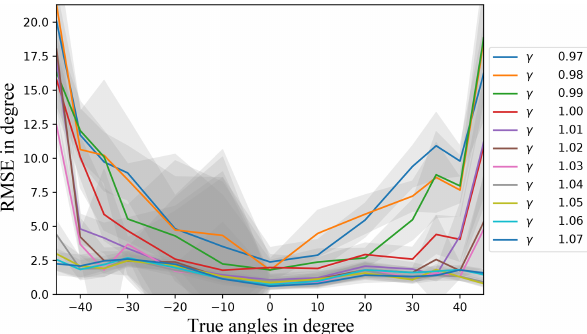
Figure 6. The root mean square error (RMSE) over all gradient angles [ − 45, + 45 ◦ ] plotted over different values for γ . Each point corresponds to the measurements of five frames evaluated five times